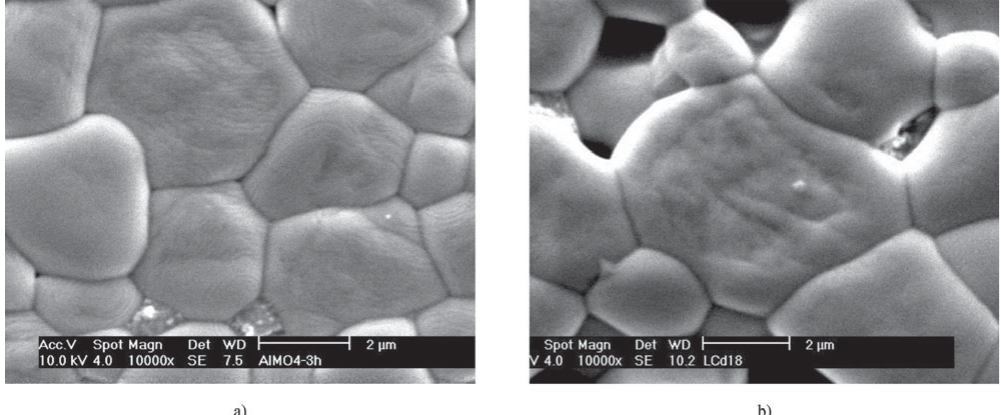
Co O powders synthe- 0.7 0.3 3